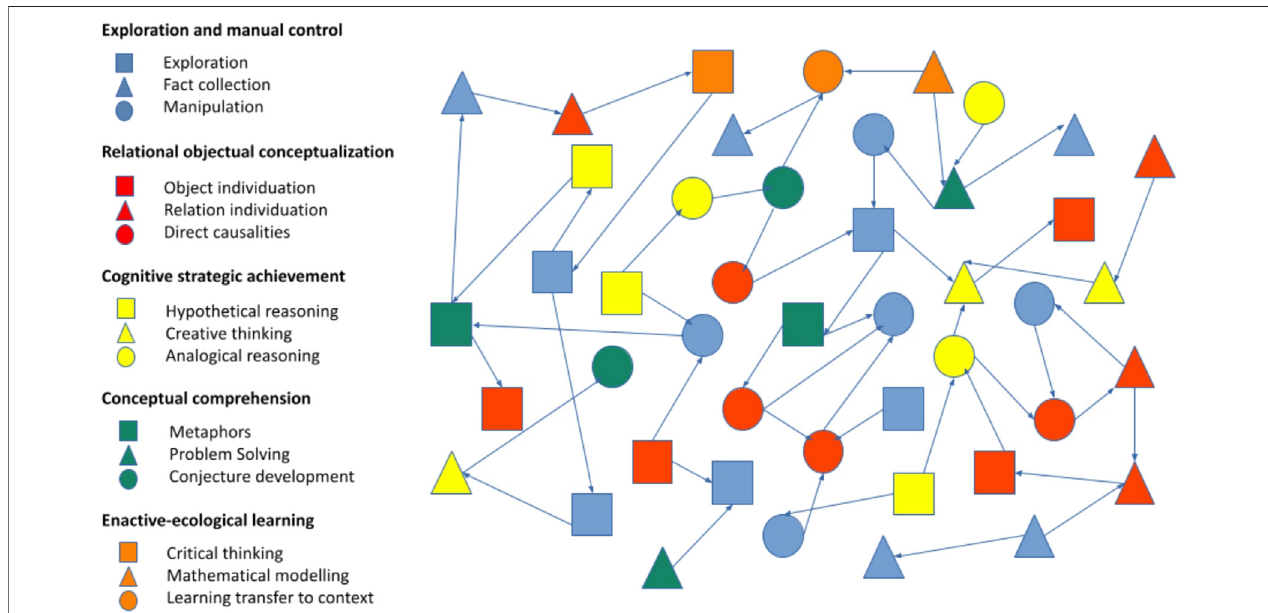
FIGURE 4 | Visual representation of a nonlinear global conceptual network of STEM/STEAM skills/actions learning activities, where different activities activate different parts of the global network, not necessarily restricted from simple to complex activities, as for example the ful fi llment of complex activities can activate activity nodes leading to more simple and basic activities coming from more complex